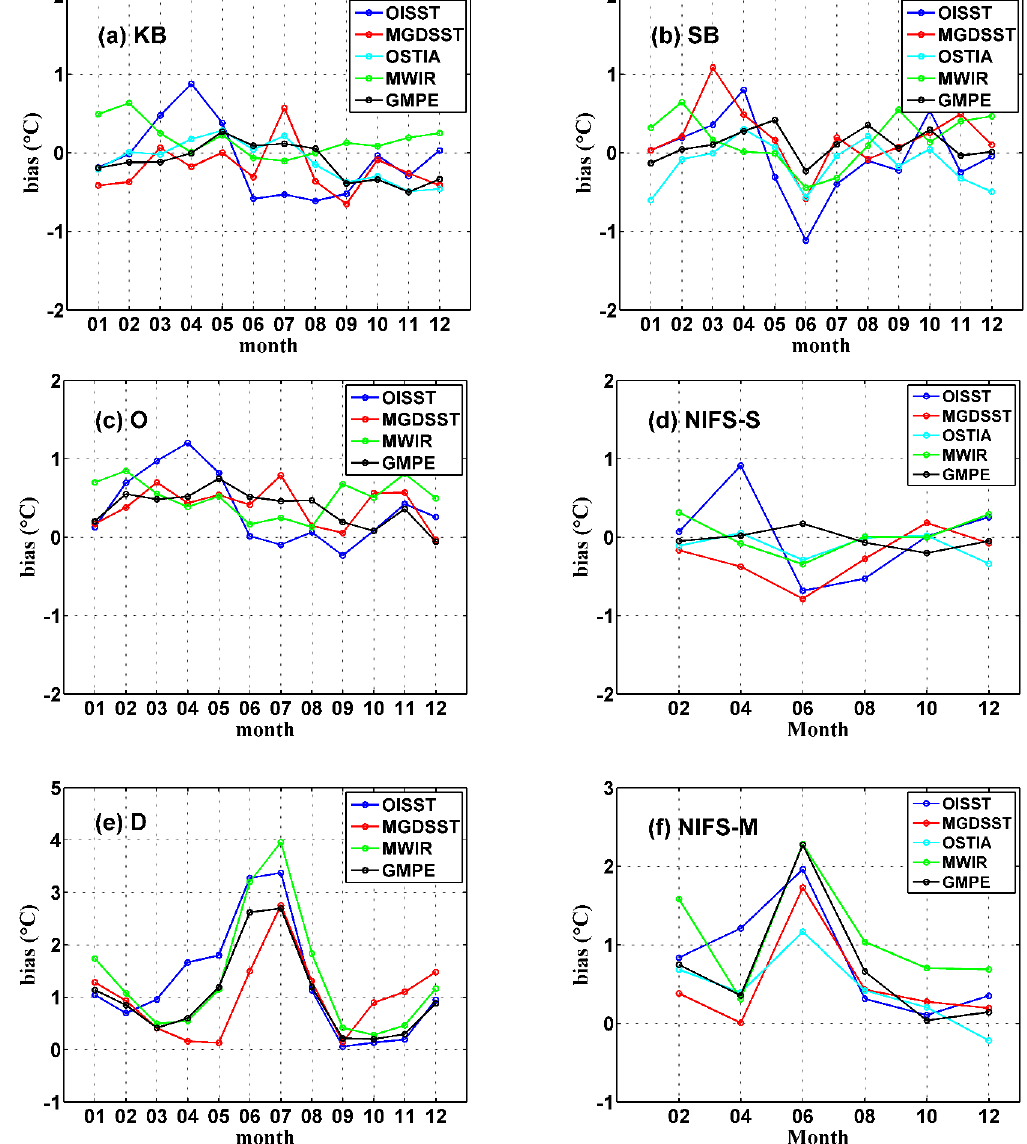
Figure 6. Seasonal variation of monthly mean bias (°C) of the gridded SST data relative to the in situ observation. ( a ) KB, ( b ) SB, ( c ) O, and ( e ) D represent the in situ observations at the ocean surface buoys. ( d ) NIFS-S and ( f ) NIFS-M represent the in situ observations at the deep stratified region ( > 50 m) and the shallow vertically mixed region ( < 50 m) stations, respectively, along the routine bimonthly observation lines of research vessels. Note that the vertical ranges in ( e ) and ( f ) are different from that in the other panels.